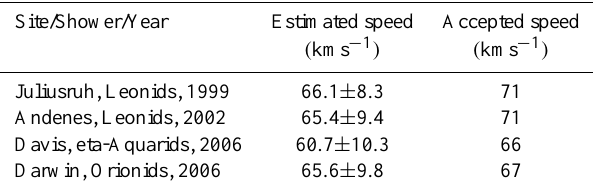
Table 1. Results of the application of Fresnel transform speed esti- mation to high speed meteor showers for low effective